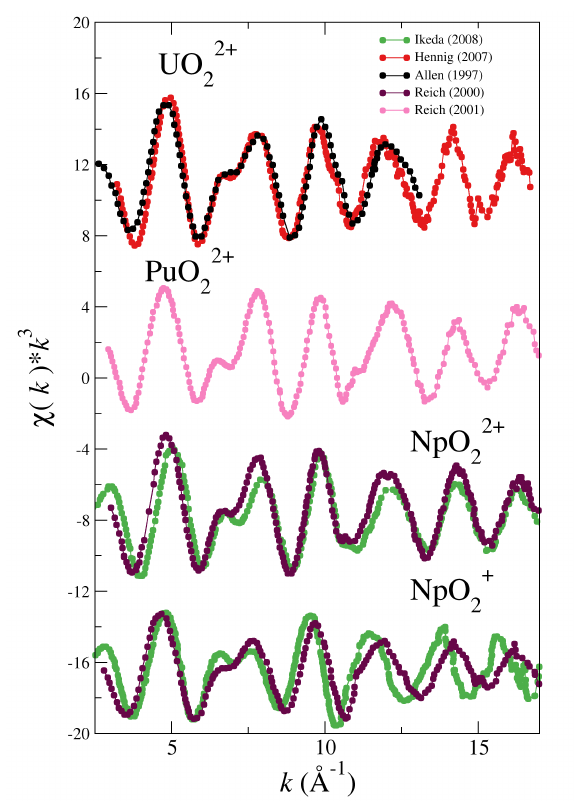
Figure 1. Experimental k 3 -weighted EXAFS spectra recorded for aqueous solutions of [UO (1997) [5] (black dotted line) and Henning (2007) [30] (red dotted line)), [PuO (pink dotted line)), [NpO ] 2+ and [NpO ] + (Ikeda (2008) [32] (green dotted line) and Reich (2000) [31] 2 2 (magenta dotted